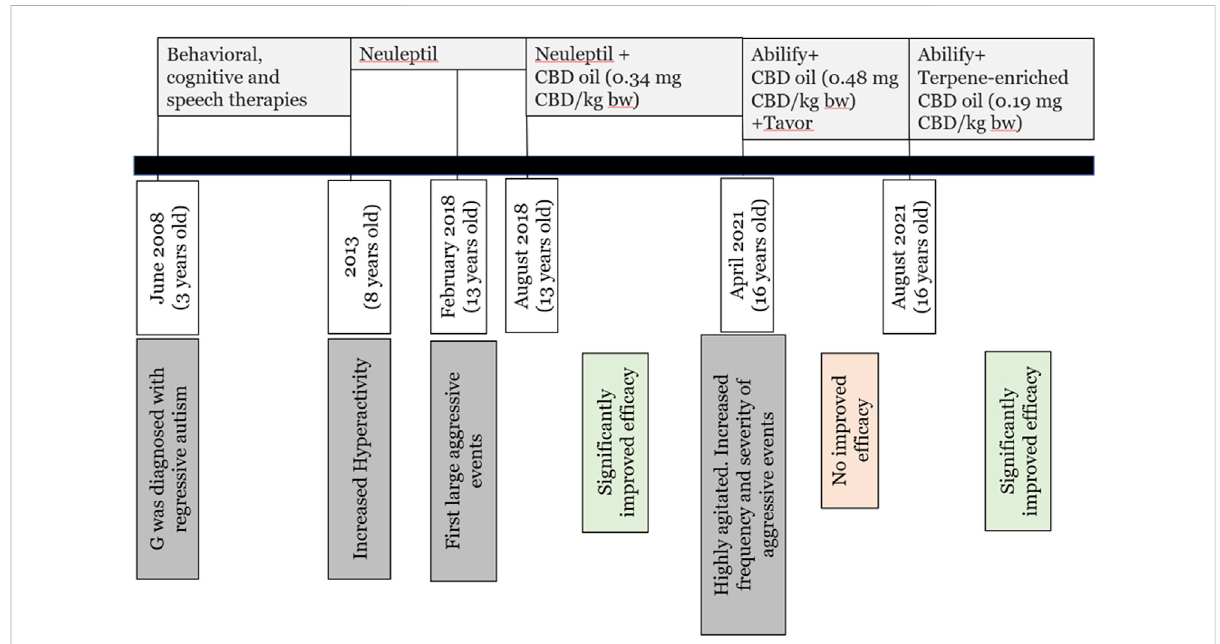
FIGURE 1 Timeline.WhitebarsrepresentimportanttimepointsalongG ’ sdevelopment.Darkgraybarsrepresenttriggeringevent.Lightgrayhorizonalbars represent given treatment. Light green/orange bars represent ef fi cacy. Time scale is not